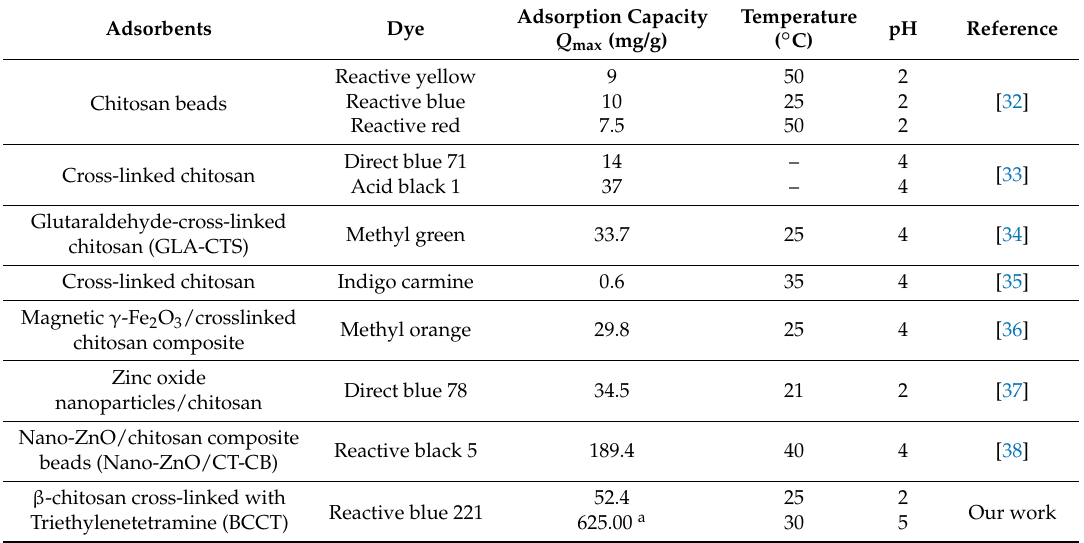
Table 4. Summary of the application of various chitosan-related nanohybrids in the dye effluent treatment. Adsorbents